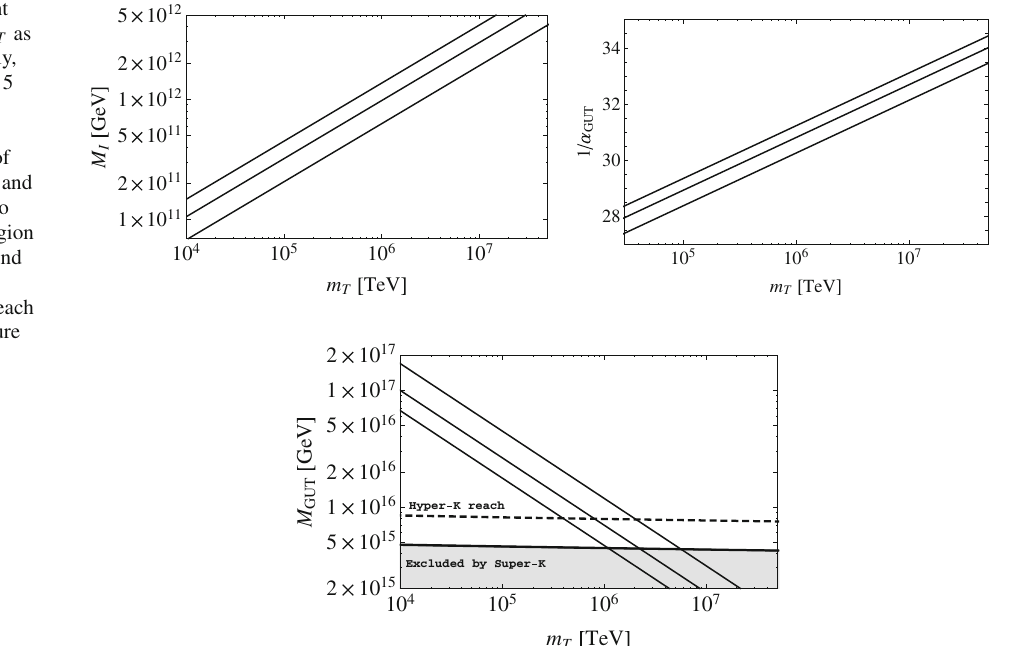
Fig. 3 Top-left and top-right panels show M I and 1 /α GUT as a function of m T , respectively, for m D = 1 TeV, 2 TeV, and 5 TeV (solid lines from top to bottom). The bottom panel shows M GUT as a function of m T for m D = 1 TeV, 2 TeV, and 5 TeV (solid lines from top to bottom). The gray shaded region is excluded by the lower bound on proton lifetime from the Super-K result. The search reach of proton lifetime by the future Hyper-K experiment, τ (cid:2) 10 × τ HK SK [61], is depicted as the dashed